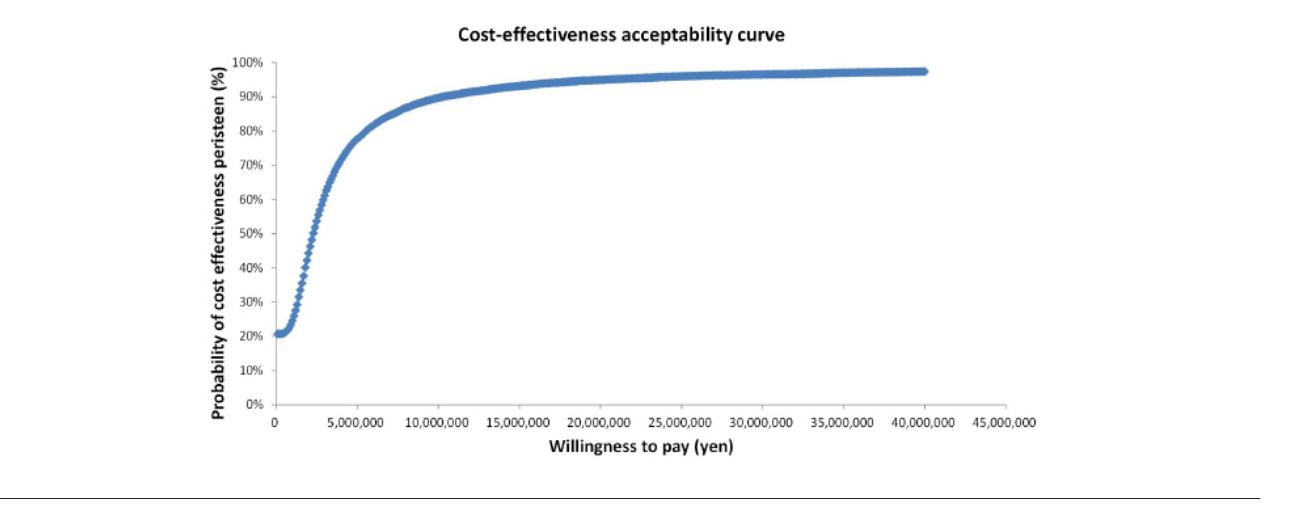
Figure 4. Cost-effectiveness Acceptability